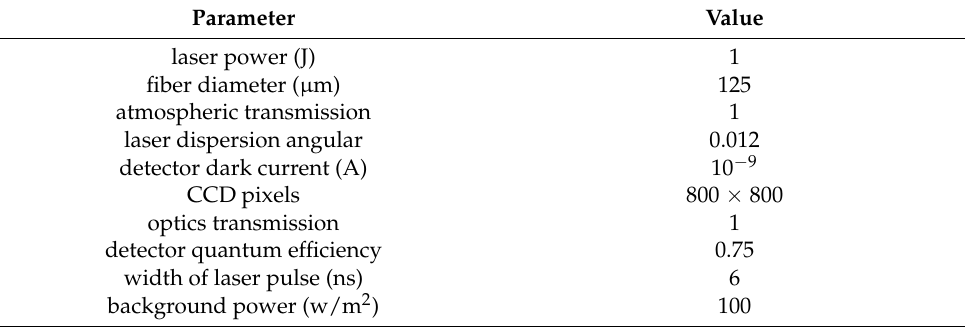
Table 1. System simulation parameters.